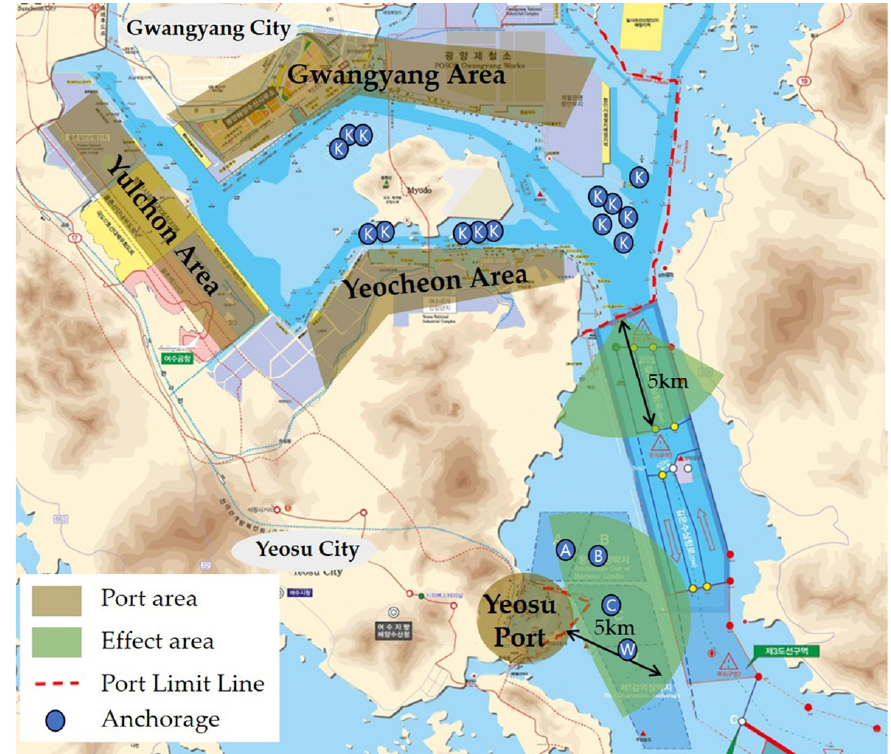
Figure 5. Gwangyang and Yeosu Ports emission effect area and facilities.